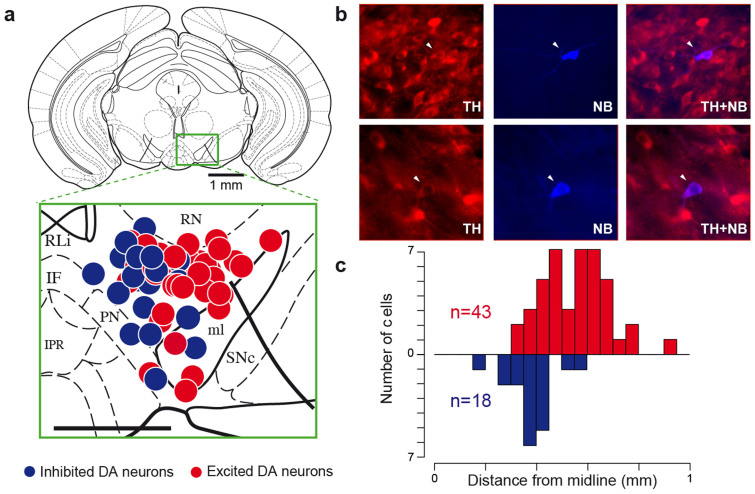
Inhibited DA neurons are located in the medial part of the VTA.(a) Coronal diagram at −3.52 mm from bregma onto which are positioned TH-positive cells labelled in vivo. Red and blue dots respectively represent excited (n = 43) and inhibited (n = 18) cells. Abbreviations: IF, interfascicular nu; IPR, interpedunc nu; ml, medial lemniscus; PN, paranigral nu; Rli, rostral linear nu; RN, red nu; SNc, substantia nigra compacta VTA, ventral tegmental area (scale bar: 0,5 mm). (b) Photomicrographs of two representative TH-positive (left) andneurobiotin-stained (middle) VTA DA neurons, one excited by nicotine (top), and the other inhibited (bottom). A merge micrograph (right) validates the DA phenotype of the recorded neuron. White arrow indicates labelled neuron. (c) Histogram of the labelled cells' anatomical distribution along the medio-lateral axis from the midline, inhibited neurons located at 378 ± 29 μm and excited neurons at 550 ± 32 μm, p < 0.001, Wilcox test.